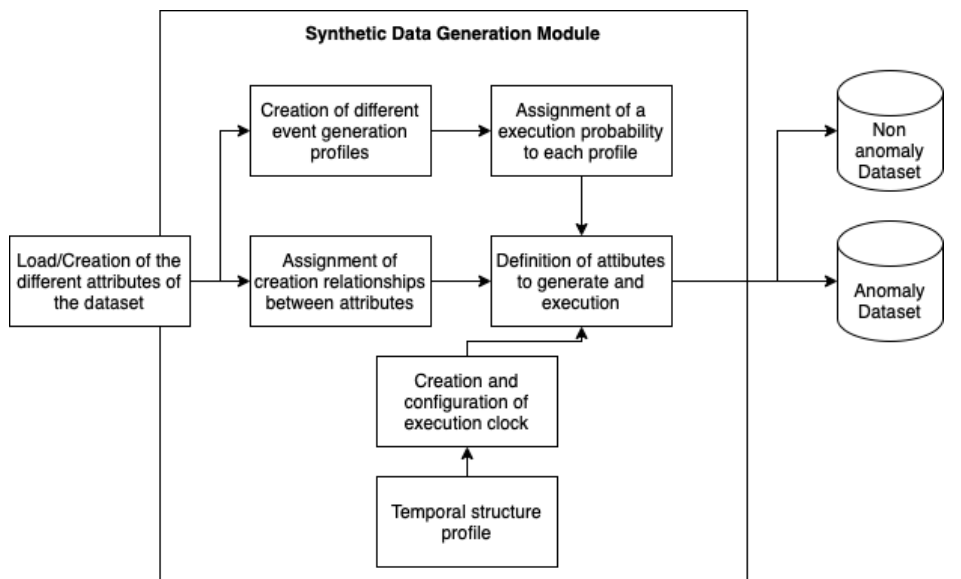
Figure 3. Modular architecture of the synthetic data generation system.